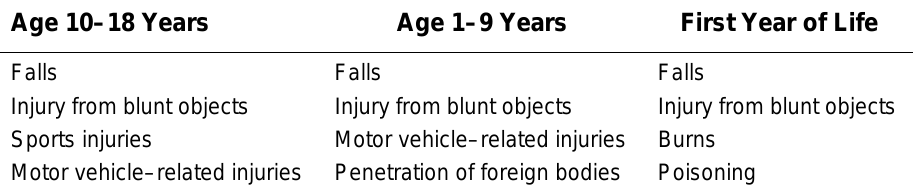
9,309 Visits in 1996 to the Department of Emergency Medicine,